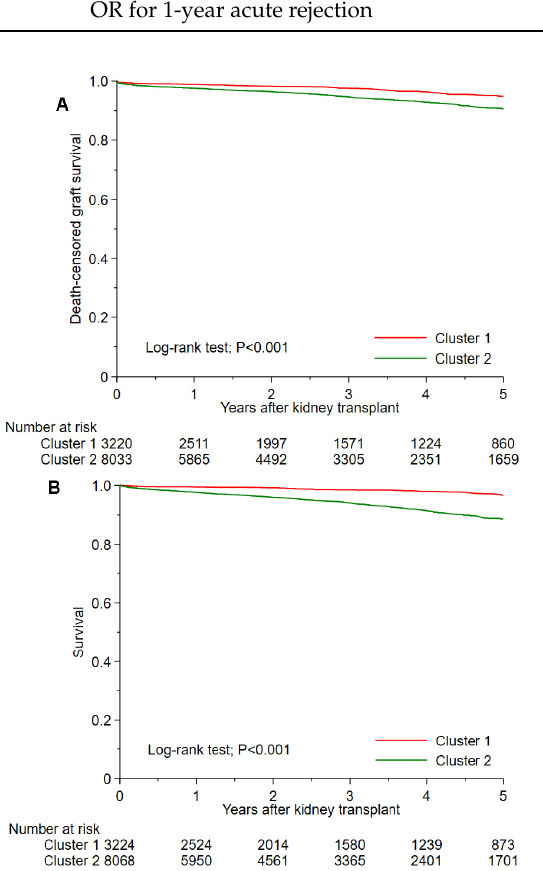
Figure 4. ( A ) Death-censored graft survival and ( B ) patient survival after kidney transplant among two unique clusters of non-citizen kidney transplant recipients in the